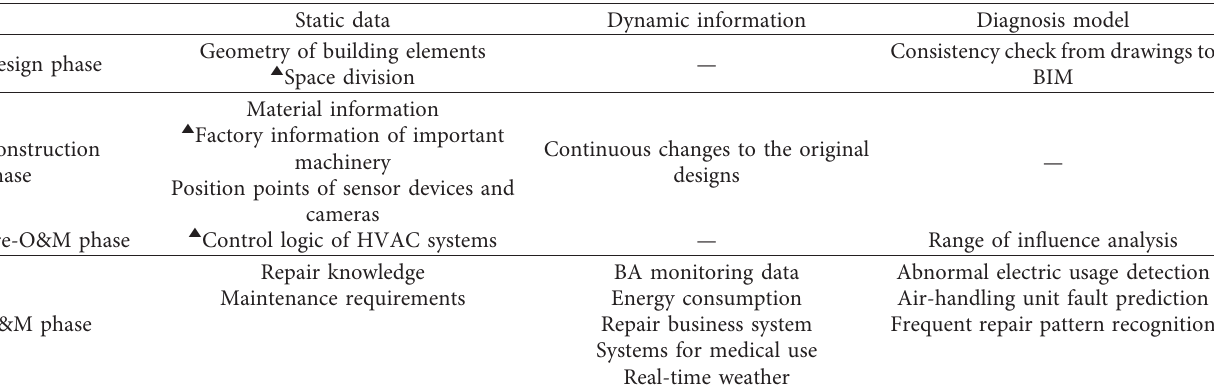
Figure 1: Main steps from real-world hospital to DT. Table 1: A nonexhaustive list of integration contents during lifecycle